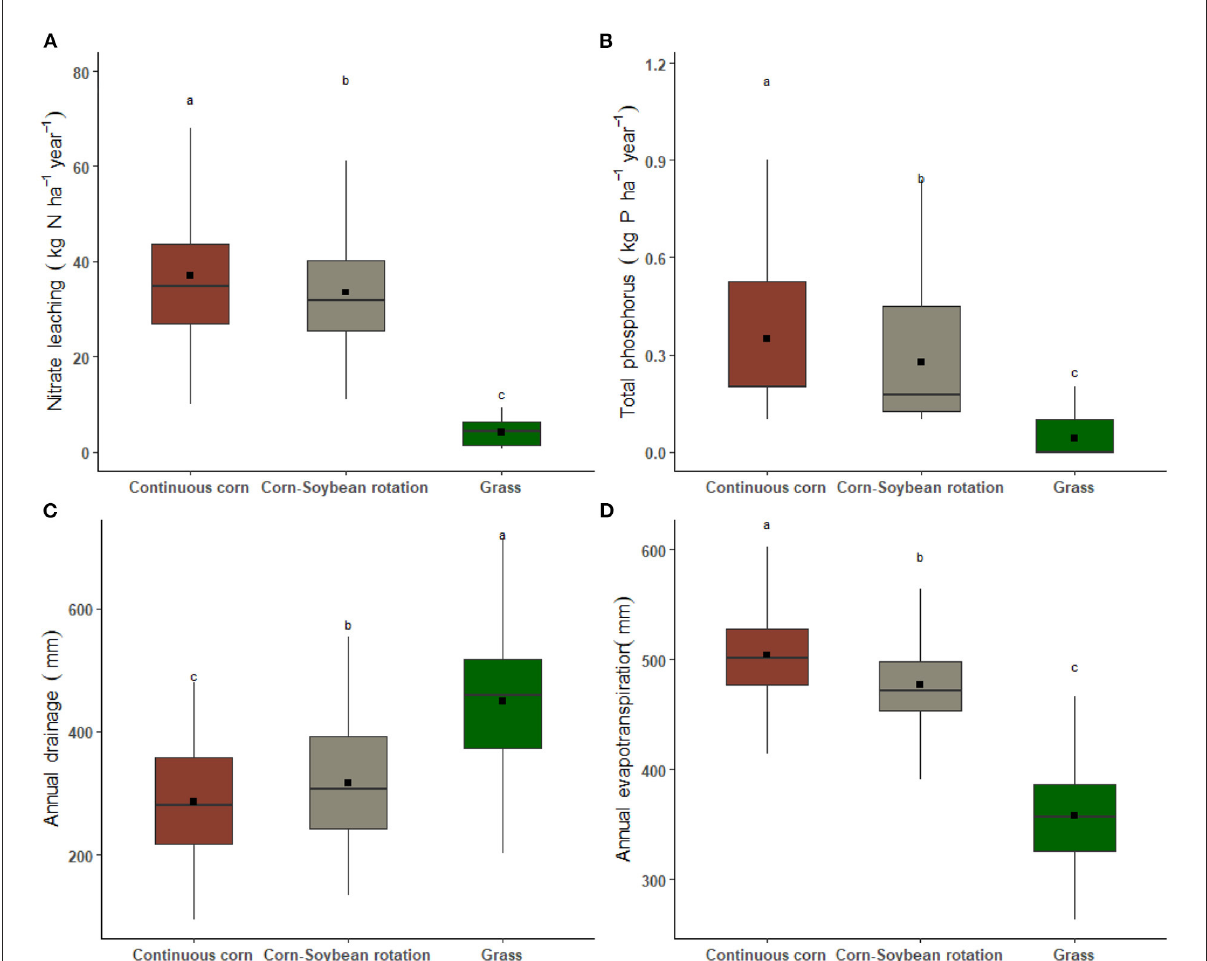
FIGURE1 (A–D) Annual averages across the modeled 38 years for (A) nitrate leaching, (B) phosphorus loss, (C) drainage, and (D) evapotranspiration across the three vegetation types on five combined farms in Marathon County, WI, USA (Cloverbelt), and Vernon County, WI, USA (Ridge & Valley). Box plots denote range of values (vertical lines), the mean (solid point), median (horizontal line), and 25th and 75th percentile range. Groups that do not share the same letters are significantly different at the 0.05